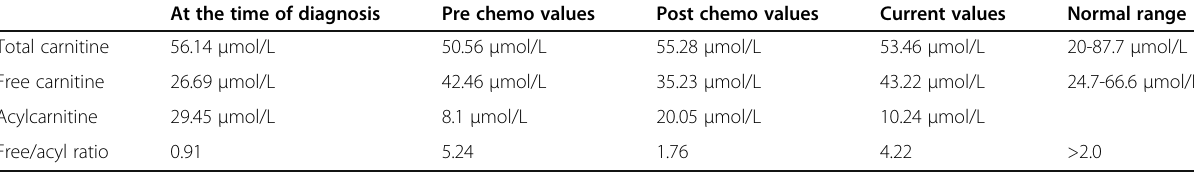
Table 2 Carnitine values before, during, and after chemotherapy At the time of diagnosis Pre chemo values Post chemo values Current values Normal